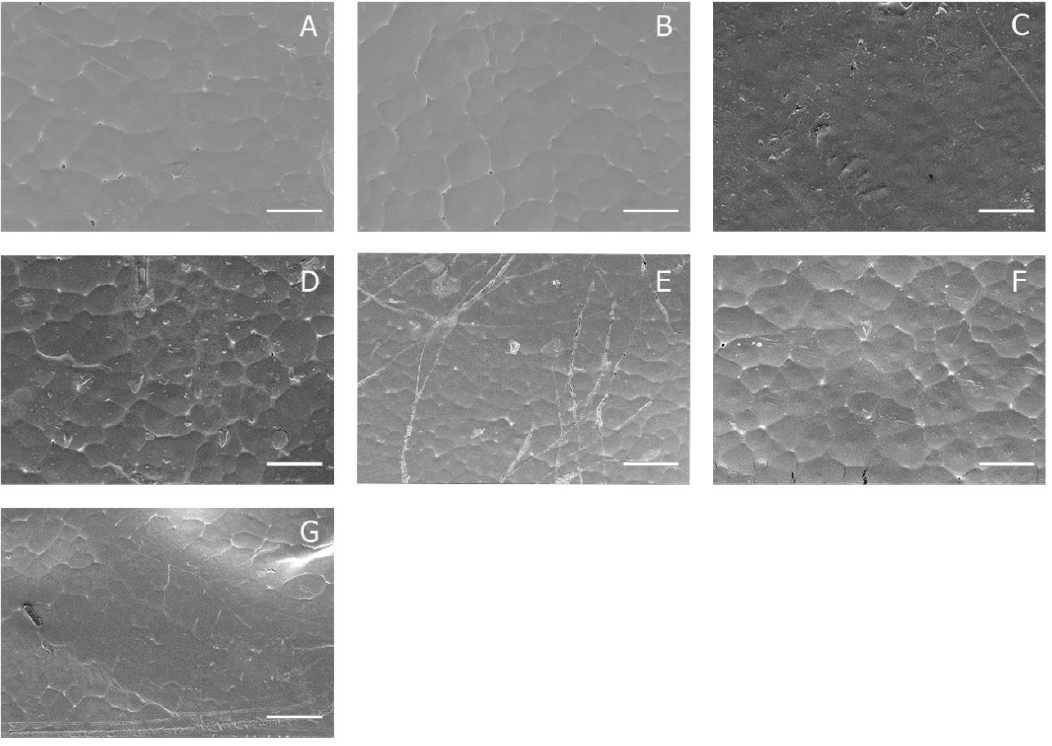
Figure 3. Scanning electron microscopy (SEM) images of PCL films; ( A ) unmodified PCL film; ( B ) film treated with the 0.1 M arginine solution for 1 h at T = 40 °C; ( C ) film treated with the 0.25 M arginine solution for 1 h at T = 40 °C; ( D ) film treated with the 0.5 M arginine solution for 1 h at T = 40 °C; ( E ) film treated with the 0.1 M arginine solution for 24 h at T = 25 °C; ( F ) film treated with the 0.25 M arginine solution for 24 h at T = 25 °C; ( G ) film treated with the 0.5 M arginine solution for 24 h at T = 25 °C. Scale bar 100 µm.